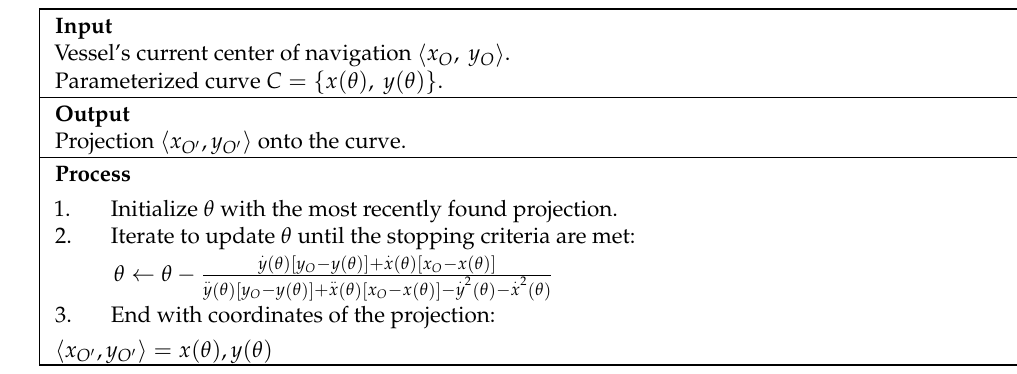
Table 2. Algorithm to find the projection of the vessel’s center of navigation onto the curve.